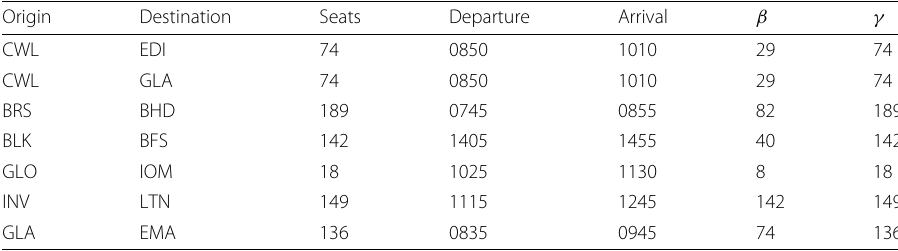
Table 1 Taint bounds with β < γ for UK flight data in Example 3